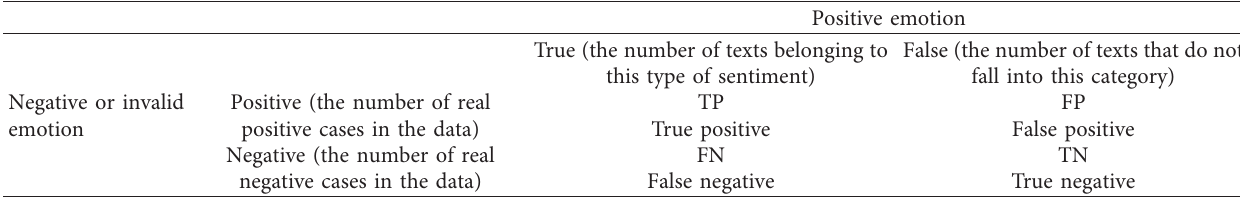
Table 1: Confusion matrix.